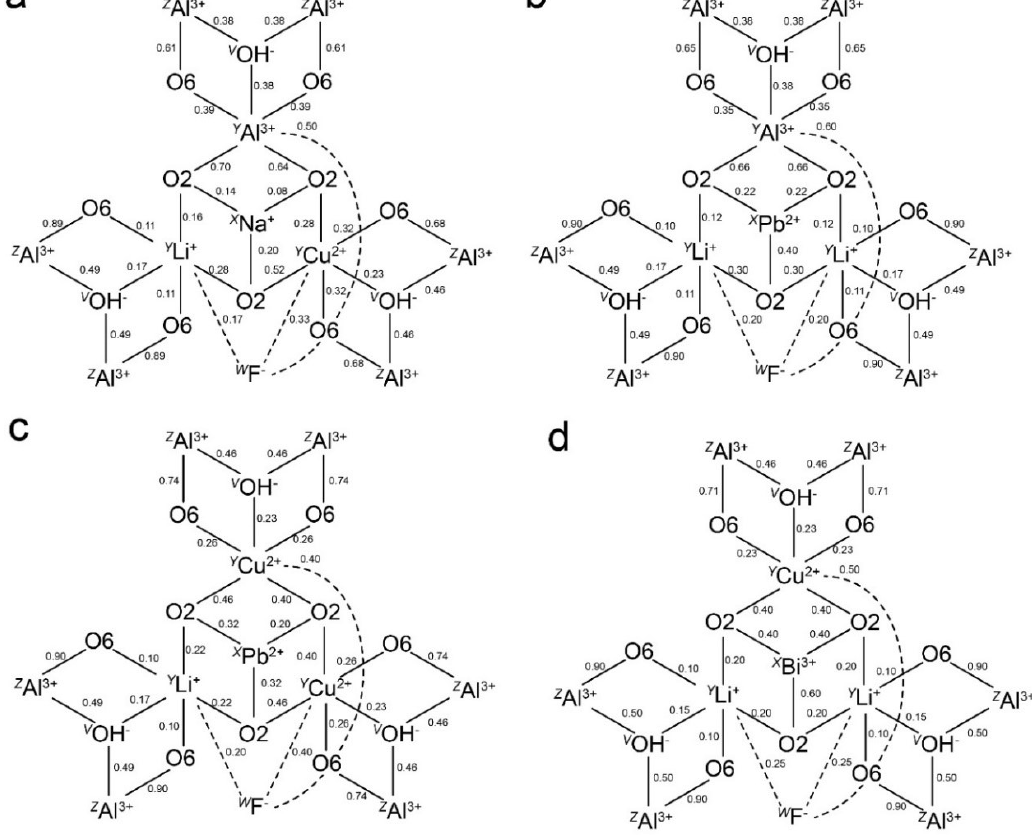
Figure 7. Structural arrangement graphs of the X-site neighborhood in the structure of ( a ) Cu-bearing fluor-elbaiteandarrangementsderivedfromitby( b )Pb 2 + Li 1 + (Na 1 + Cu 2 + ) − 1 , ( c )Pb 2 + Cu 2 + (Na 1 + Al 3 + ) − 1 and ( d ) Bi 3 + Li 1 + (Na 1 + Al 3 + ) − 1